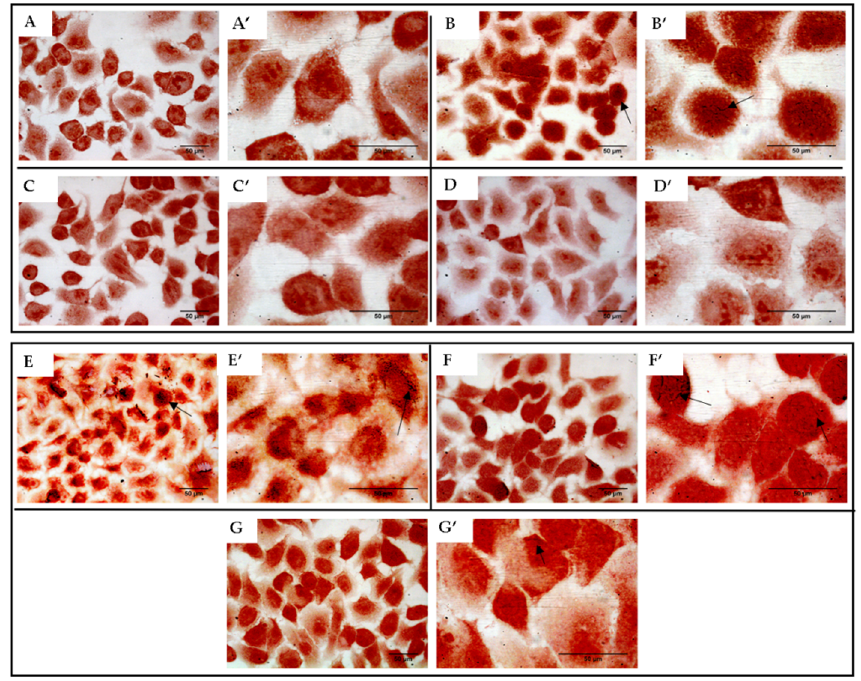
Figure 8. S. aureus ATCC 6538 (B–D) and MRSA 8 (E–G) adhesion to human lung A549 cells visu- alized using Gram staining. Bacterial adhesion, in the different experimental conditions, was com- pared to negative control (A). 40X magnification A-G; 100X magnification A’-G’. (A,A’): unin- fected cells (negative control); (B,B’): A549 cells infected with S. aureus ATCC 6538 (positive con- trol); (C,C’): A549 cells infected with S. aureus ATCC 6538 and simultaneously treated with 32.00 μ g/mL of K. lappacea root extract (KLRE); (D,D’): A549 cells infected with S. aureus ATCC 6538 and simultaneously treated with 64.00 μ g/mL of KLRE; (E,E’): A549 cells infected with MRSA 8 (posi- tive control); (F,F’): A549 cells infected with MRSA 8 and simultaneously treated with 32.00 μ g/mL of KLRE; (G,G’): A549 cells infected with MRSA 8 and simultaneously treated with 64.00 μ g/mL of KLRE. Adherent colonies of S. aureus to A549 cell surface (black arrows).